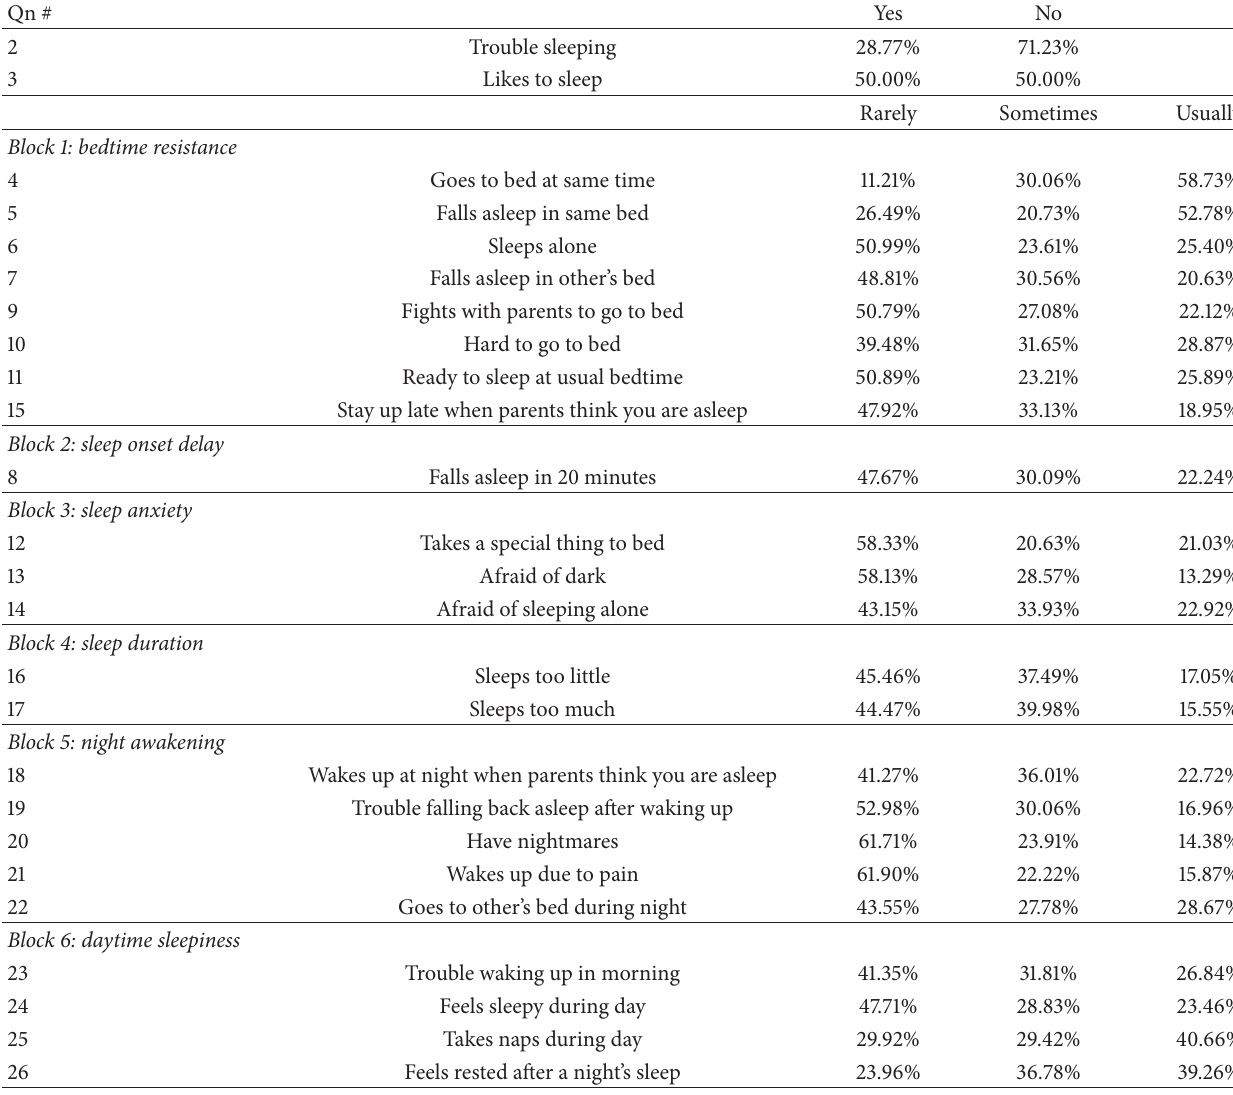
Table 3: Responses to the Children’s Sleep Habits Questionnaire from middle school